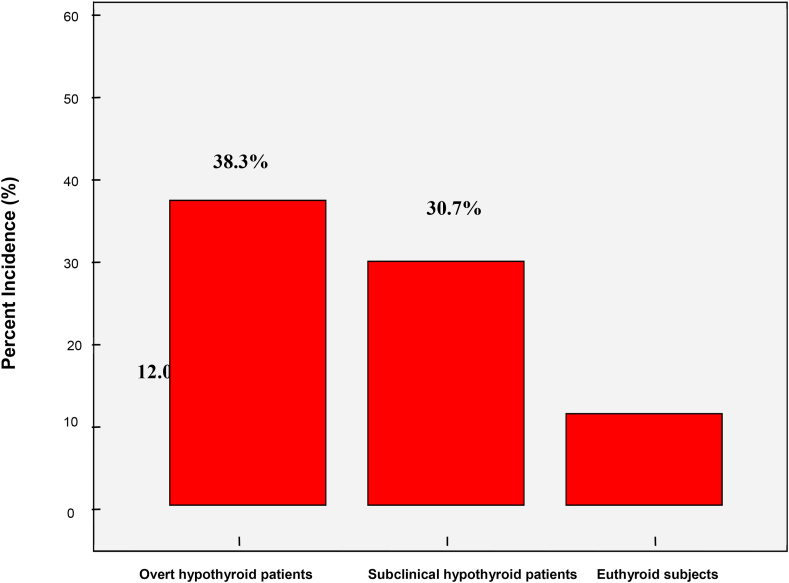
Distribution of positive parental history of coronary artery disease by thyroid status.